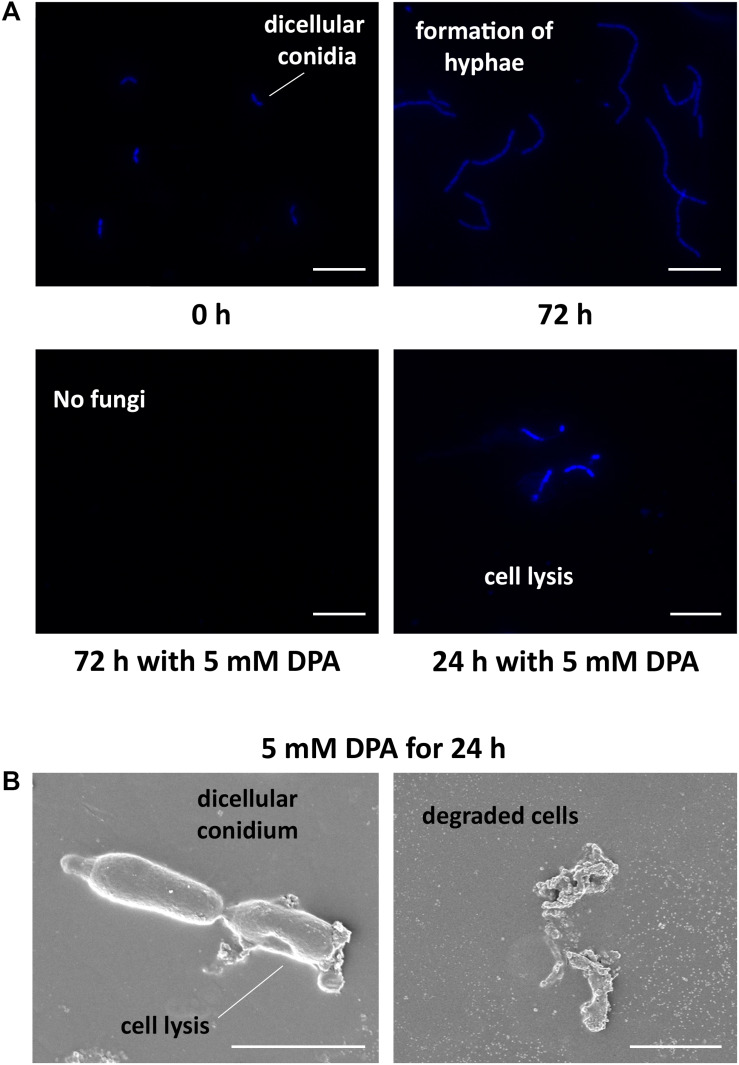
Microscope observations of V. pyri cell cycle and antifungal effects of DPA. (A) Observations of DAPI-stained V. pyri dicellular conidia and hyphae formation using a fluorescent microscope. The treatment of V. pyri conidia with 5 mM DPA (pH = 5) caused the apoptosis of V. pyri. Scale bar = 10 μm. (B) Observations of the effects of 5 mM DPA on V. pyri cell wall using scanning electron microscope (SEM). The treatment was carried out for 24 h at pH = 5. DPA caused the distorsion of V. pyri cell wall, producing the cell lysis. Scale bar = 2 μm.